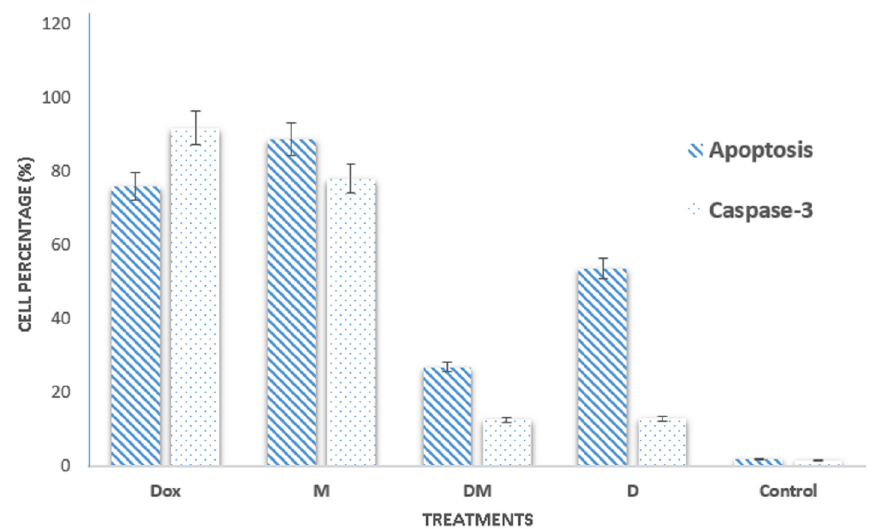
Figure 5. Correlation between percentage of apoptosis and caspase 3 activation in breast cancer T47D cells after treatment with extracts of Ancorina sp. Doxorubicin (Dox), Methanol (M), Dichloromethane:Methanol (1:1) (D:M), Dichloromethane (D), and negative control (control). Value after ± and error bar show standard deviation of two replications.